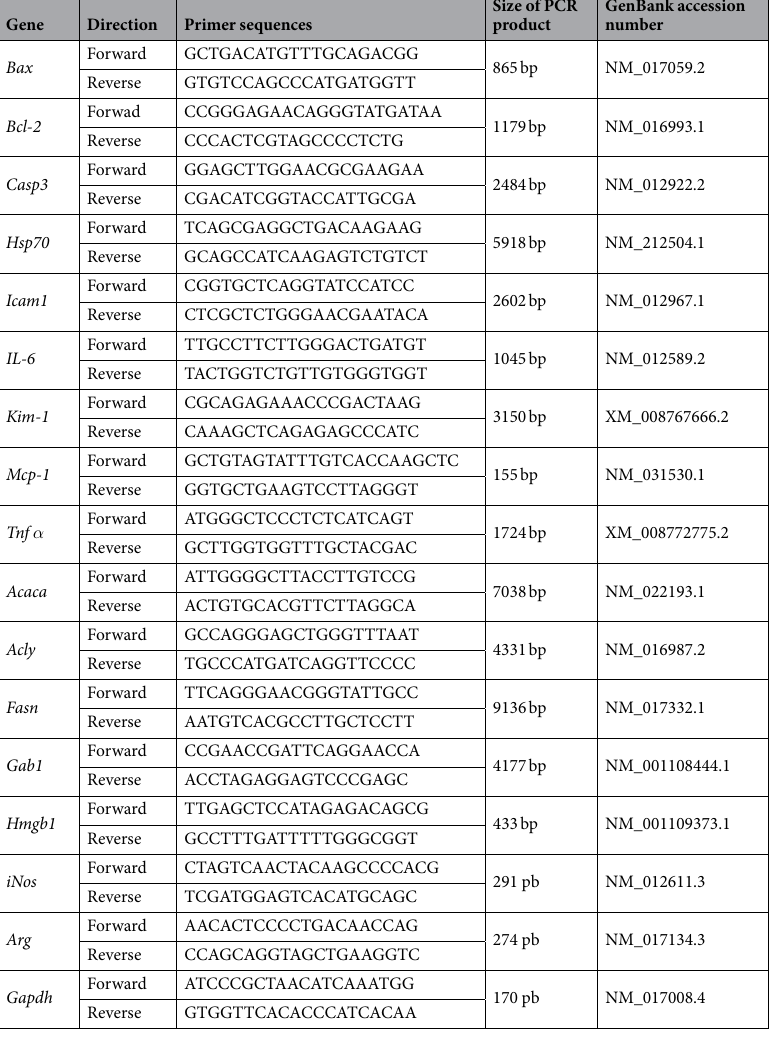
Table 2. Primers used for